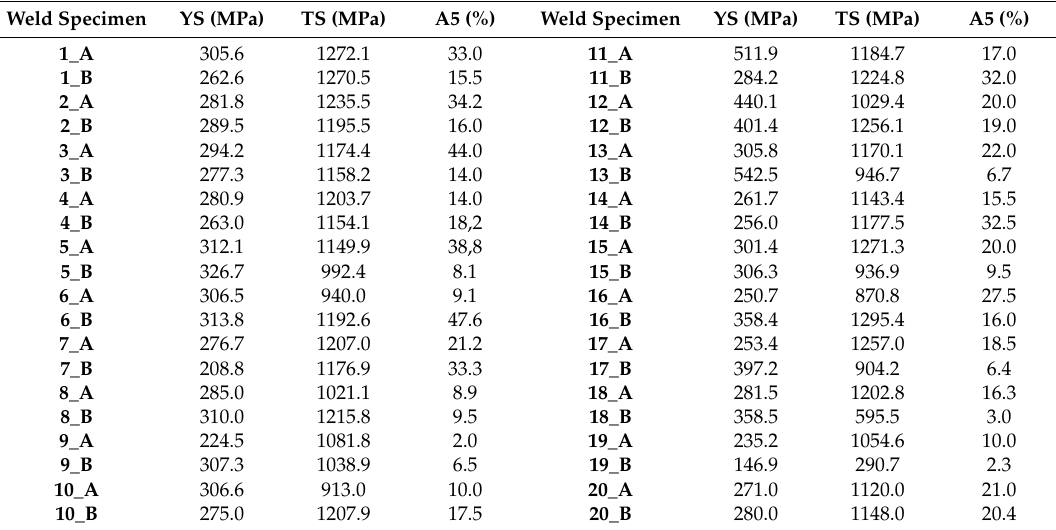
Table 5. Mechanical properties of samples C (see Figure 1).